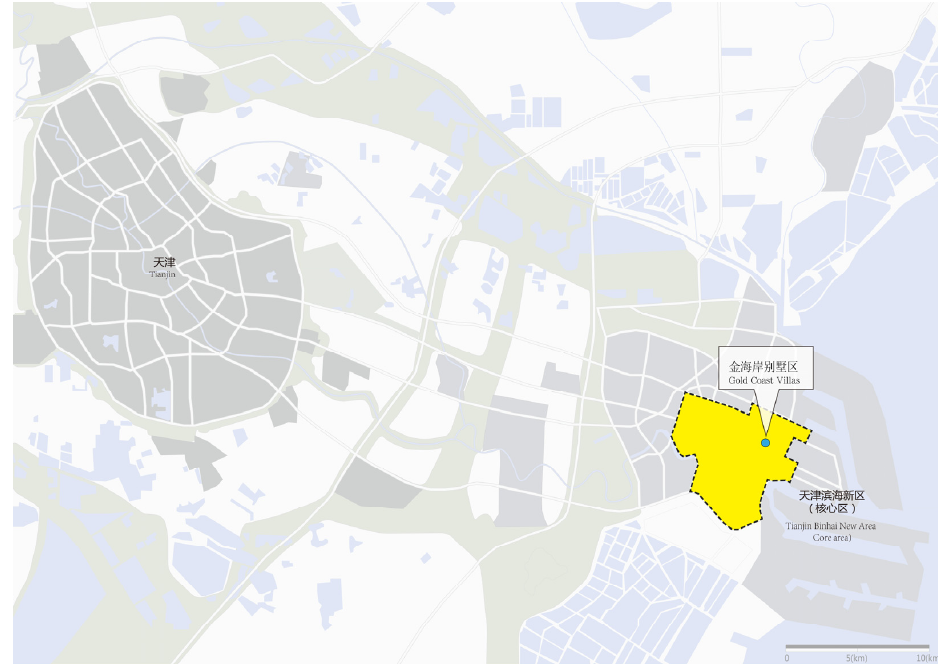
Figure 8. Location of Tianjin Tianbao Gold Coast Community.